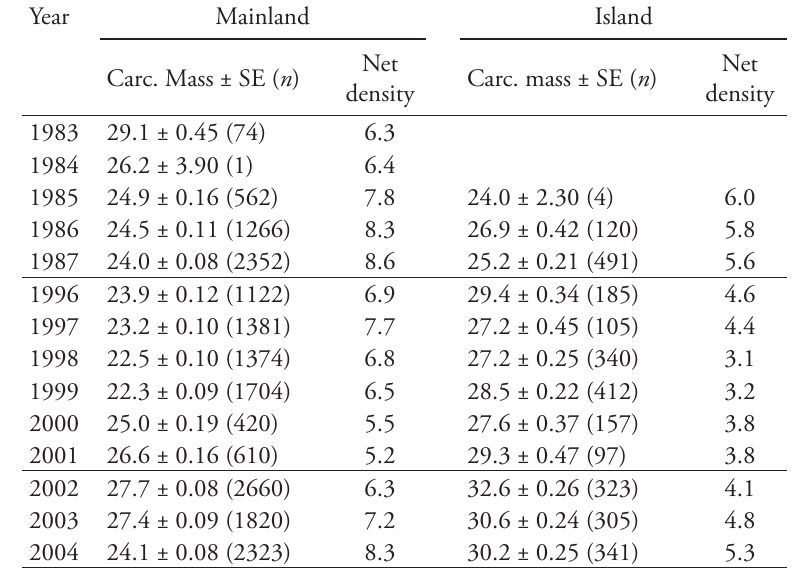
Table 1. Mean yearly carcass mass ± standard error in kg, sample size (n) pro- vided in brackets and annual net density by